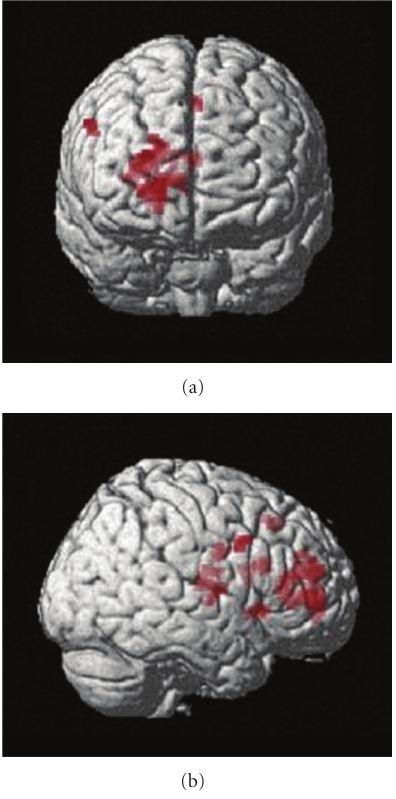
Figure 3: Anterior (top) and left lateral (bottom) views of the group activation map showing increased di ff erential activity before the facilitation programme, for the contrast between past and control conditions ( P = 0 . 01, k >